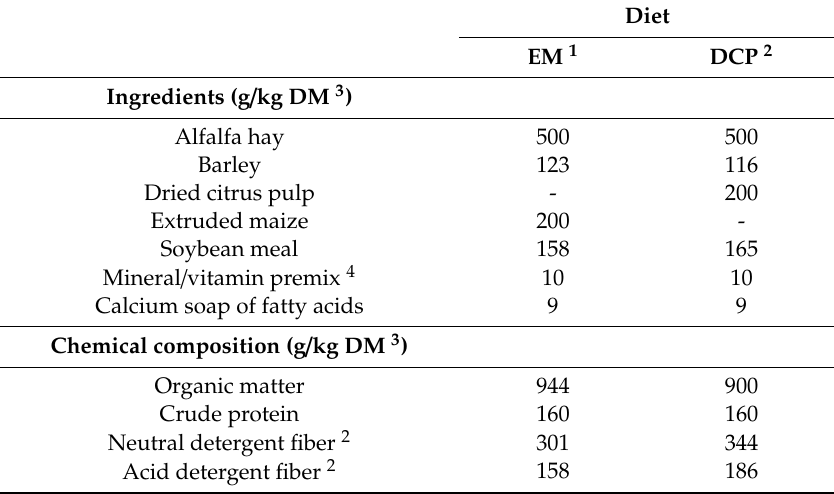
Table 2. Ingredient and chemical composition of the experimental diets incubated in the Rusitec